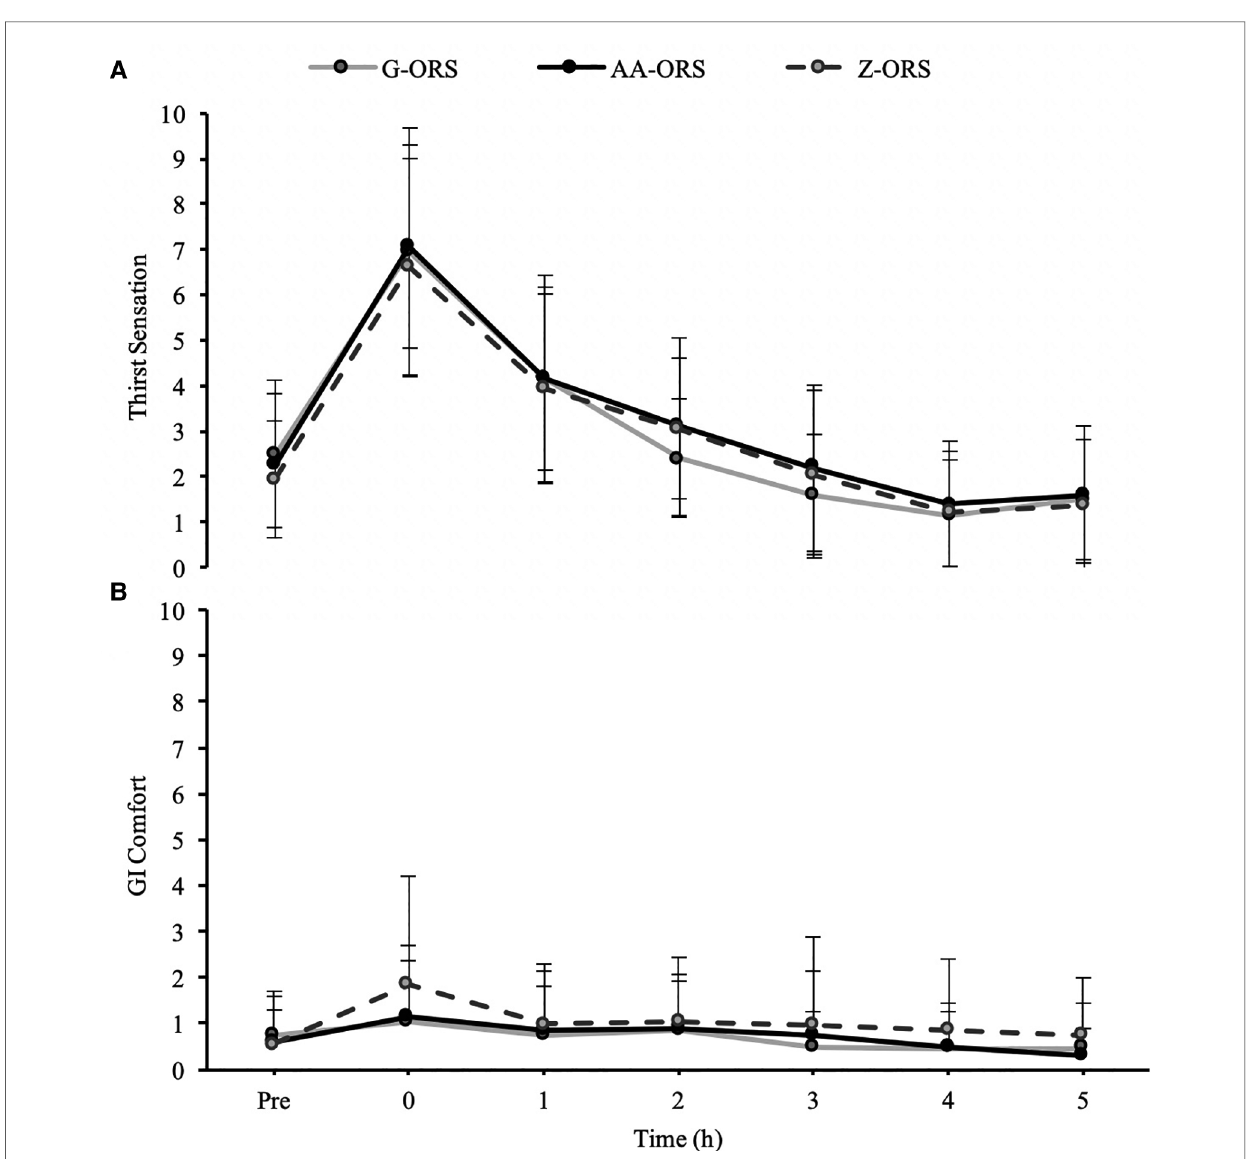
FIGURE 1 Subjective sensation of ( A ), thirst and ( B ) gastrointestinal (GI) comfort at baseline (Pre) and during the rehydration